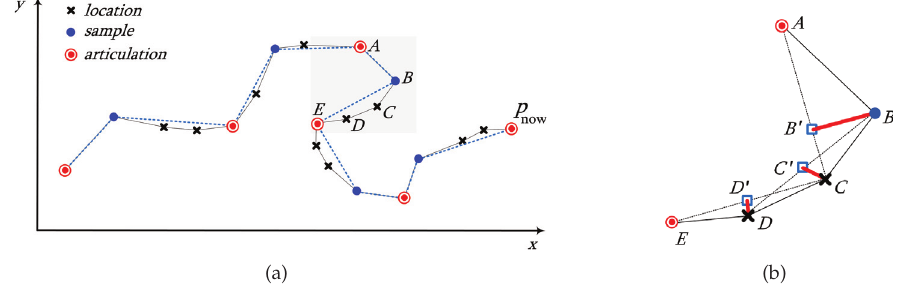
Figure 7: Scaling using synchronous Euclidean distance: (a) Keeping samples that denote locally significant changes in movement. (b) For each batch of points buffered in a frame transition, at most m k of those with maximal SED values are